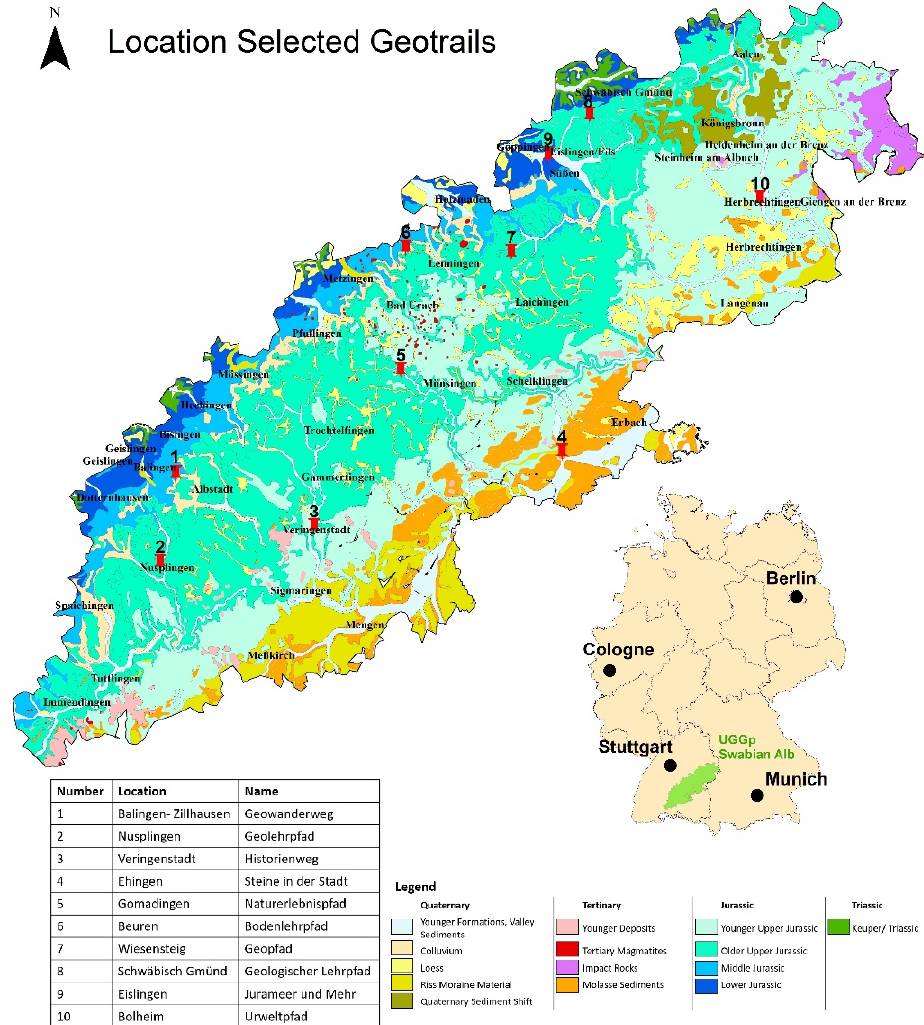
Figure 12. UGGp Swabian Alb Geopark and geotrails selected for the study (Julian Stolz 2022).